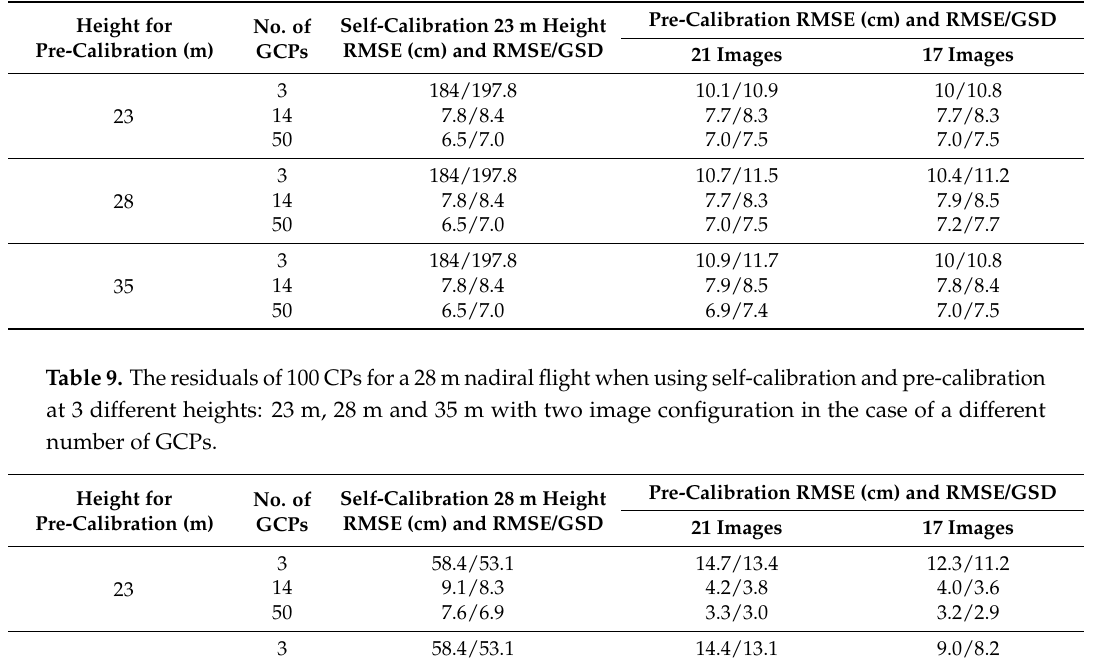
Table 8. The residuals of 87 CPs for a 23 m nadiral flight when using self-calibration and pre-calibration at 3 different heights: 23 m, 28 m and 35 m with two image configuration in the case of a different number of GCPs.